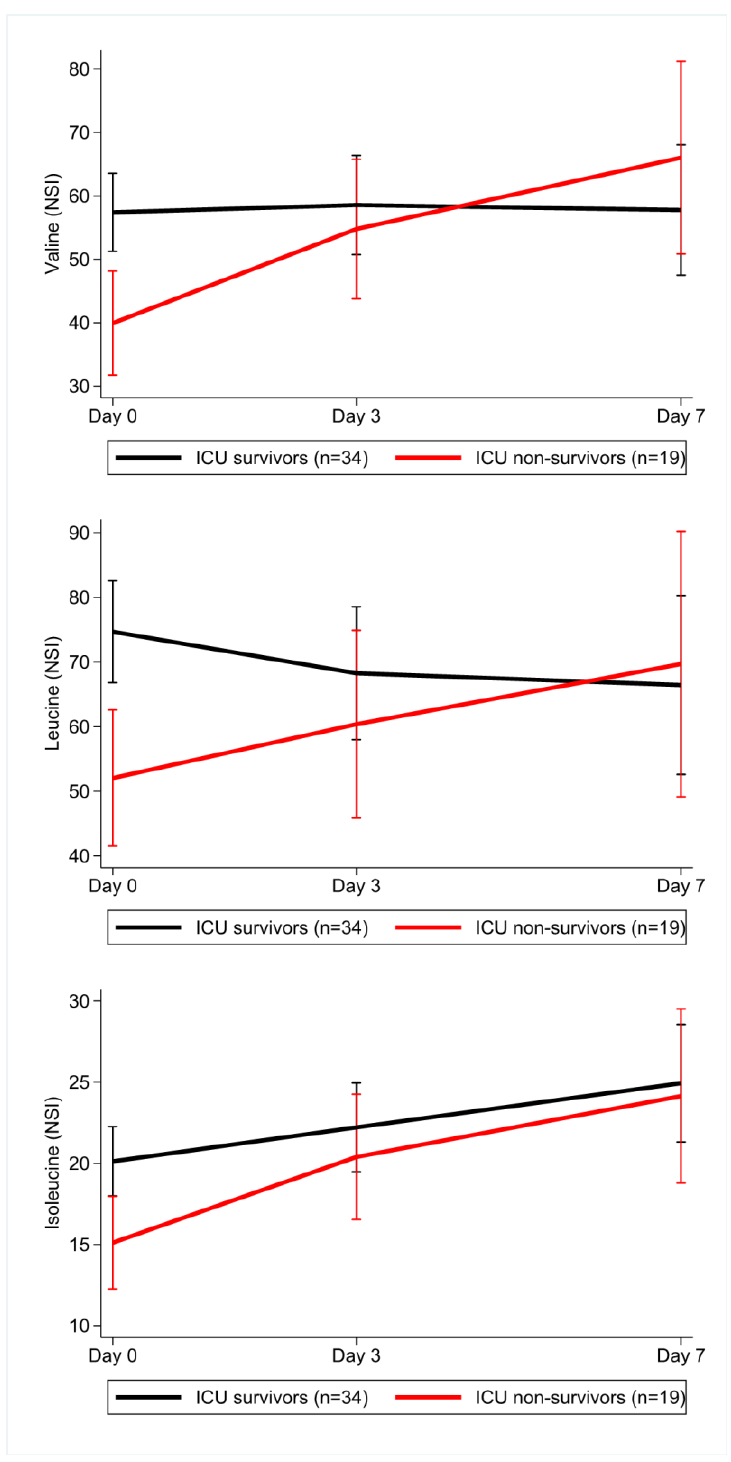
Figure 5. Longitudinal data of branched-chain amino acid levels. Mean levels of branched-chain amino acids (top panel: valine; middle panel: leucine; bottom panel: isoleucine) over time in sepsis survivors (black line) and sepsis non-survivors (red line) from day 0 to day 3 and 7 after admission. Survivors compared to non-survivors had significantly higher levels of branched-chain amino acids on day 0. Note that in the non-survivor cohort, lower branched-chain amino acids were associated with decreased time until death.